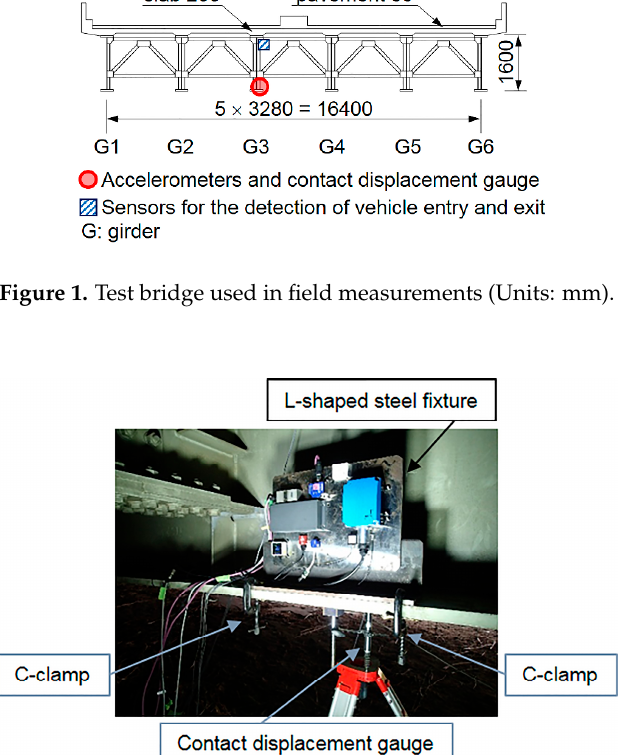
Figure 2. Installation of accelerometers and contact displacement gauge. Table 1. Specifications of contact displacement gauge to verify displacement obtained from acceleration.